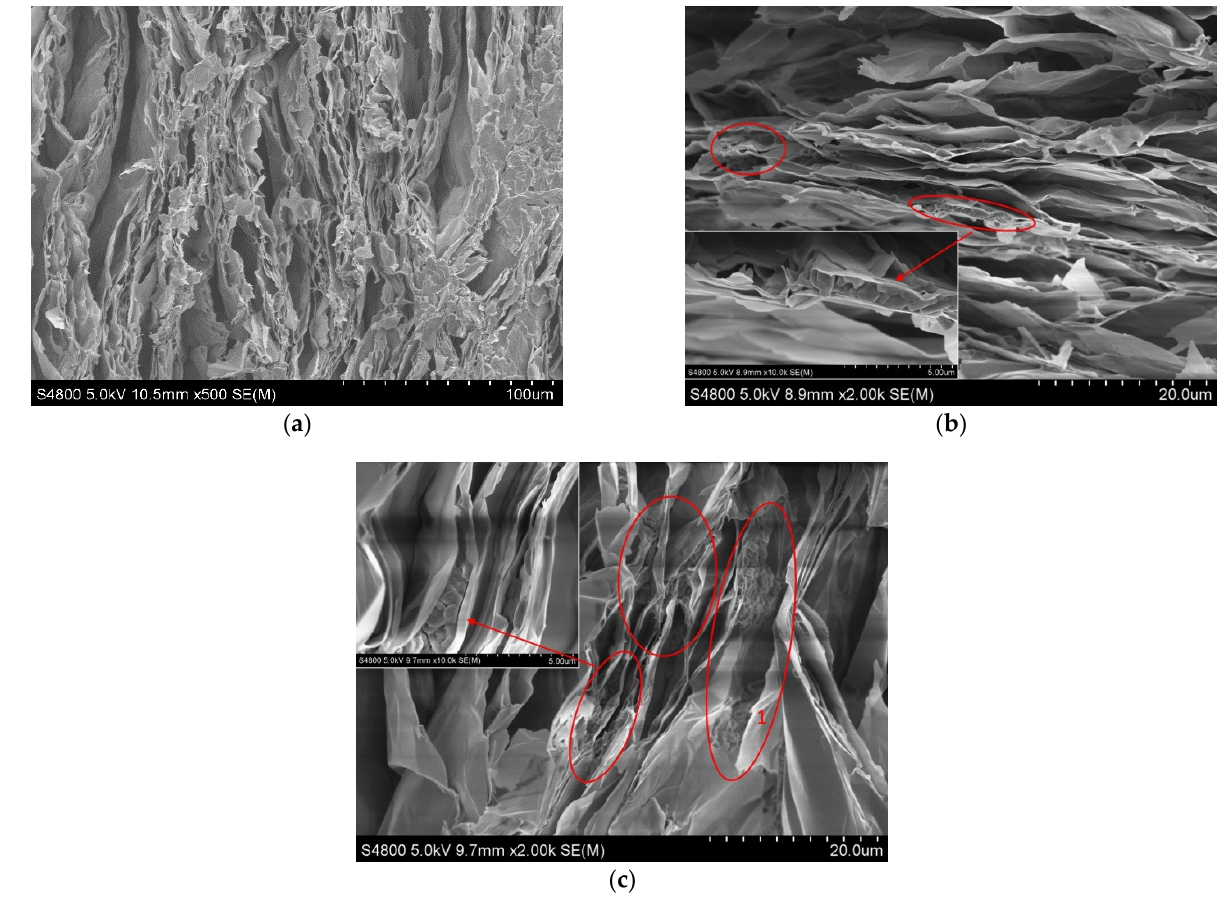
Figure 9. SEM images of EVM, KE1-2 and KE1-4 samples cross-sections. ( a ) EVM; ( b ) KE1-2; and ( c ) KE1-4.